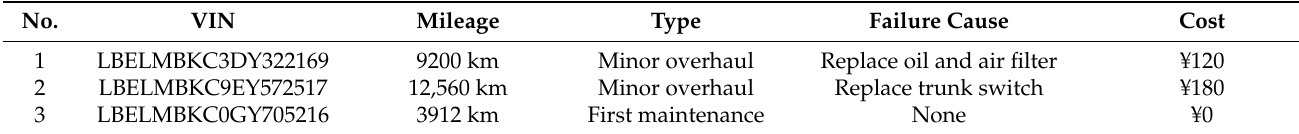
Table 3. Part of the maintenance information for the Hyundai vehicles.